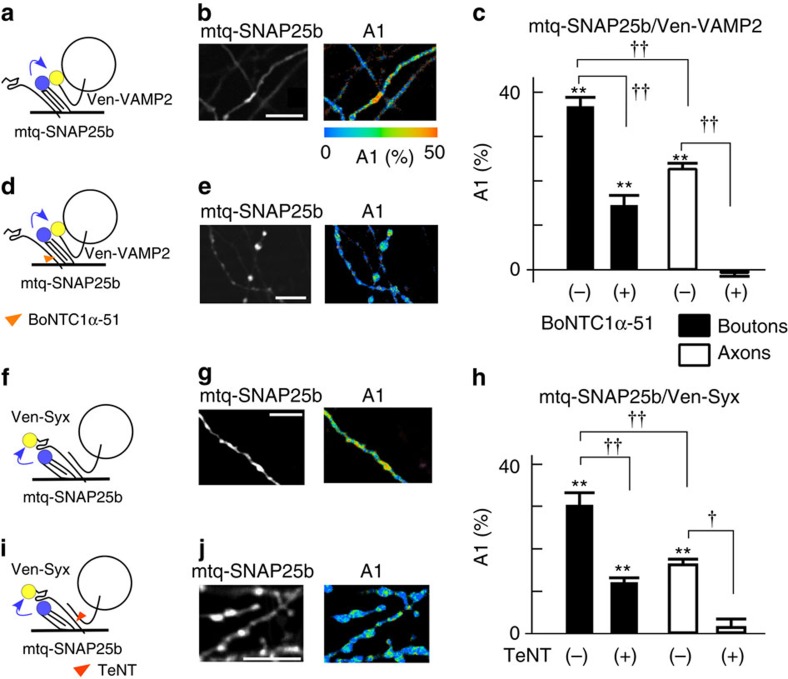
FRET/2pFLIM of mtq-SNAP25-based probes for SNARE complexes.(a,d) Schematic drawing of mtq-SNAP25/Venus-vesicle-associated membrane protein 2 (Ven-VAMP2) probes and the action of BoNTC1α-51. (b,e) Fluorescence and A1 fraction images of mtq-SNAP25/Ven-VAMP2-expressing boutons in the absence (b) and presence of BoNTC1α-51 (e) (scale bars, 5 μm). (c) The A1 fractions of mtq-SNAP25/Ven-VAMP2-expressing boutons (filled; 36.7±2.2%; 20 boutons at the endogenous expression level of VAMP2; Supplementary Fig. 3f) and axons (open; 22.7±1.3%; 22 axons) and those in the presence of BoNTC1α-51 in boutons (14.5±2.2%; 24 boutons) and in axons (−0.4±1.1%; 17 axons). **P<0.001 for control boutons and axons and **P=0.0001 for BoNTC1α-51-treated boutons using the Wilcoxon signed-rank test versus 0%. Using the Kruskal–Wallis test on the four groups, we obtained a P value of <0.00001, and the effects of BoNTC1α-51 on boutons and axons were †P=0.03 and †P=0.04, respectively, using Scheffé's test. ††P=0.004 between control boutons and axons and ††P=0.002 between BoNTC1α-51-treated boutons and axons. (f,i) Schematic drawing of mtq-SNAP25/Ven-Syx probes and the action of TeNT. (g,j) Fluorescence and A1 fraction images of mtq-SNAP25/Ven-Syx-expressing boutons in the absence (g) and presence of tetanus toxin (TeNT; j) (scale bars, 5 μm). (h) The average A1 fractions of mtq-SNAP25/Ven-Syx-stained boutons (filled; mean±s.e.=29.5±3.1%; 21 boutons with the mean expression of Ven-Syx of 139 a.u.; Supplementary Fig. 3h) and axons (open; 16.2±1.3%; 28 axons), those of boutons in the presence of TeNT (12.0±1.1%; 45 boutons with the mean expression level Ven-Syx of 138 a.u.) and of axons (2.4±1.7%; 15 axons). **P<0.01 for control boutons, axons and TeNT-treated boutons using the Wilcoxon signed-rank test versus 0%. Using the Kruskal–Wallis test on the four groups, we obtained a P value of <0.00001. The A1 values of boutons and axons were different (††P=0.004) in the absence of the toxin, and the toxin's effects were significant: ††P=0.0007 and †P=0.04 for boutons and axons using Scheffé's test.